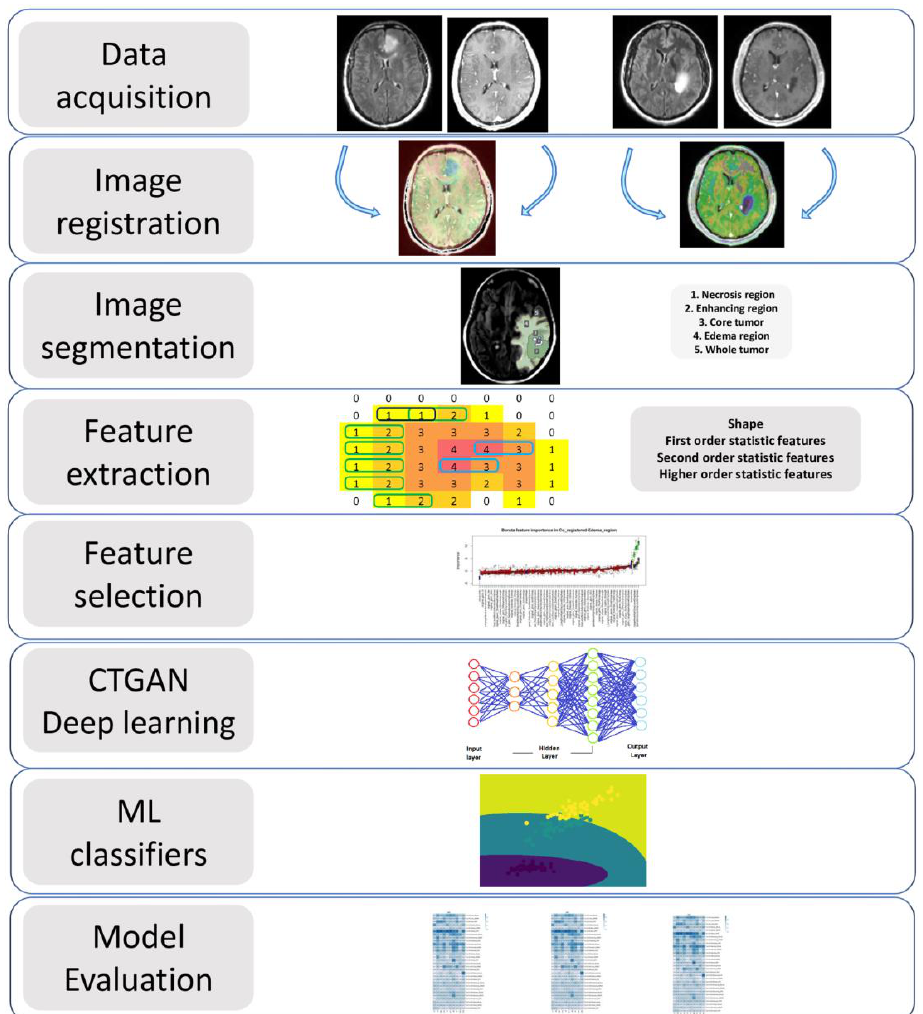
Cancers 2023 , 14 , x FOR PEER REVIEW Figure 1. The overview of the image processing and radiomics pipeline. Figure 1. The overview of the image processing and radiomics pipeline.